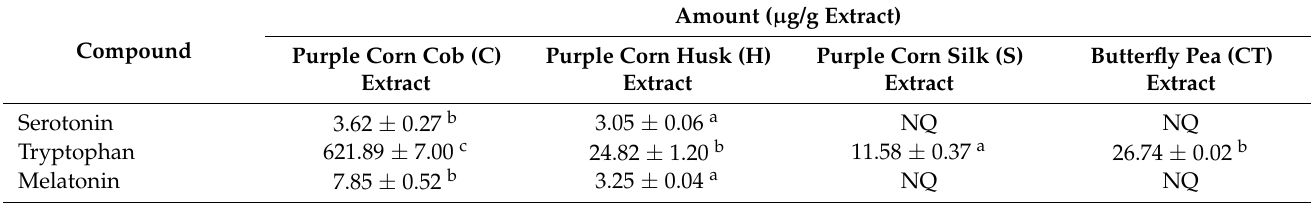
Table 2. The content of serotonin, tryptophan and melatonin in each individual extract analyzed using